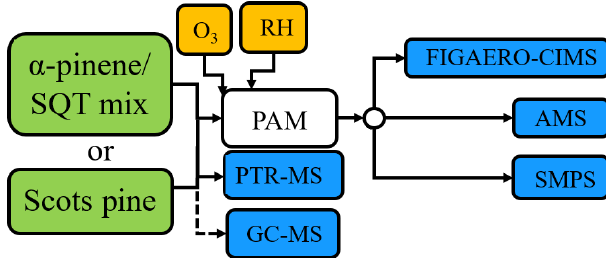
Figure 1. Measurement setup used in the experiments. Abbrevia- tions in the picture are explained in the main text (Sect. 2), except for ozone-containing air (O 3 ) and humidified air